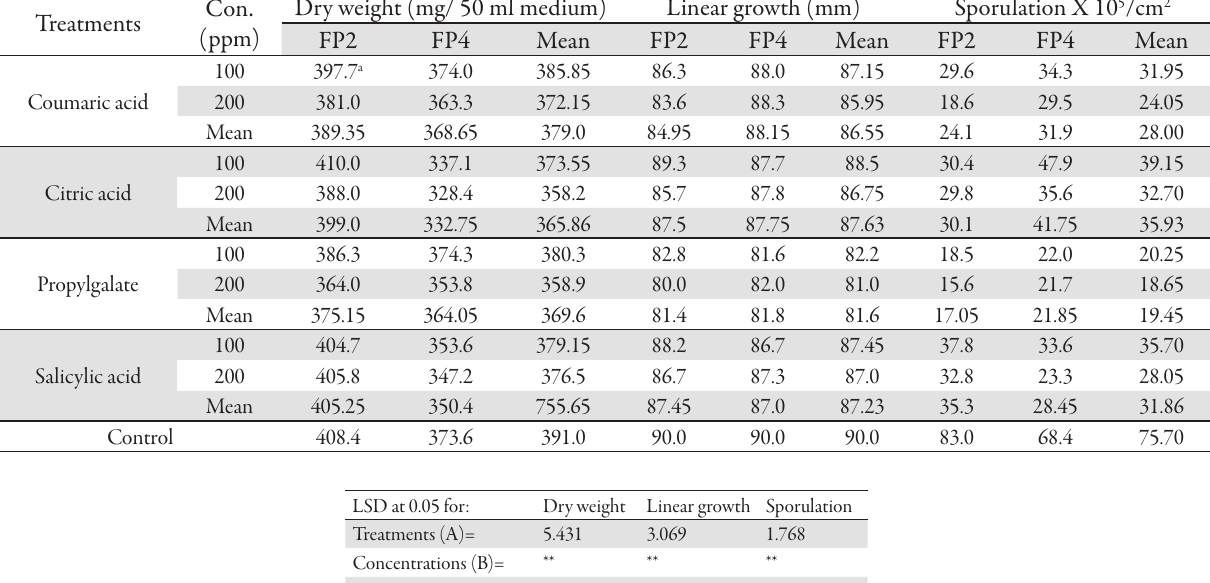
Tab. 6. Effect of antioxidant compounds on dry weight, linear growth and spore formation of Fusarium solani isolate FP2 and Fusarium oxysporum isolate FP4 grown on Czapek’s medium